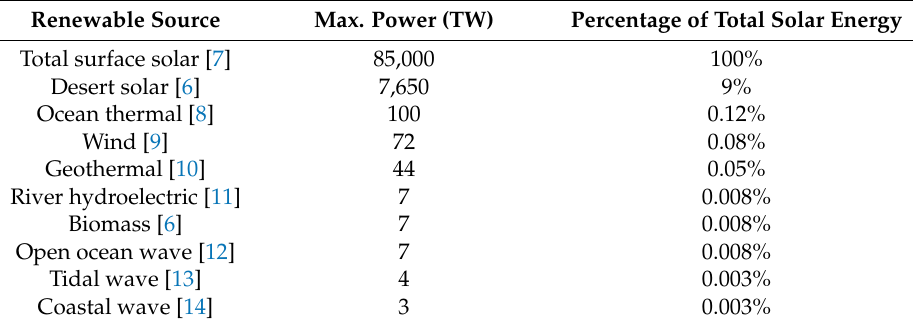
Table 1. Power from different renewable sources in the earth